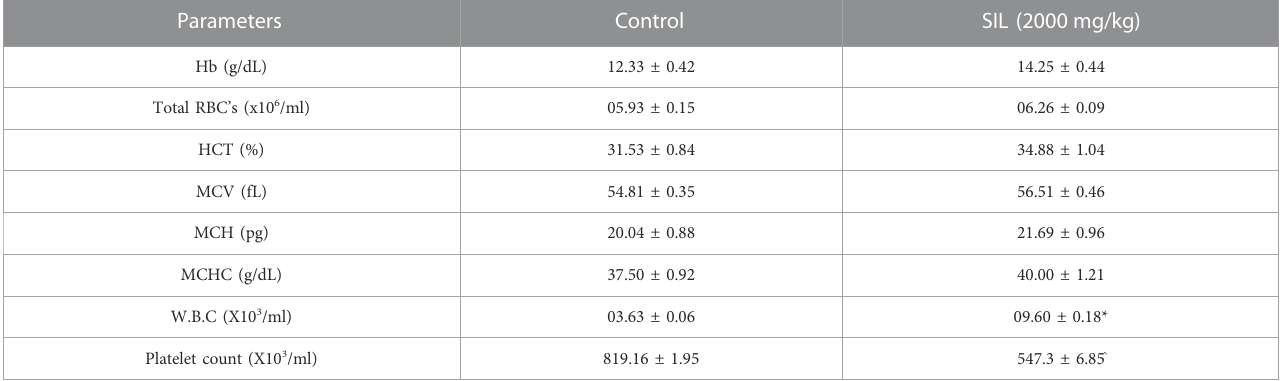
TABLE 3 Estimation of hematological parameters in acute oral toxicity.